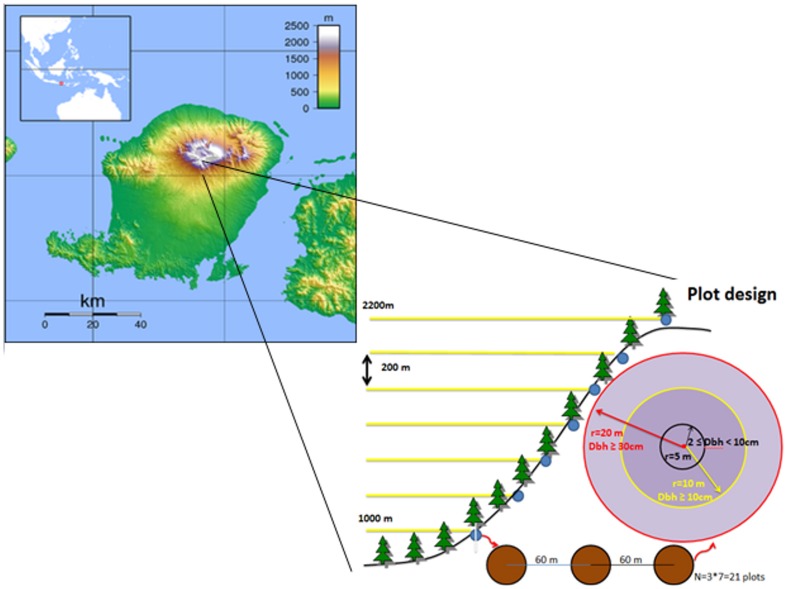
Map of the Island of Lombok and Mt. Rinjani, the study site, and the sample design.It was not possible to sample vegetation below 1000 m because of human disturbance and above 2000 m were fire-maintained grasslands. Access was only possible through using the main hiking trail on the north slope of the mountain.